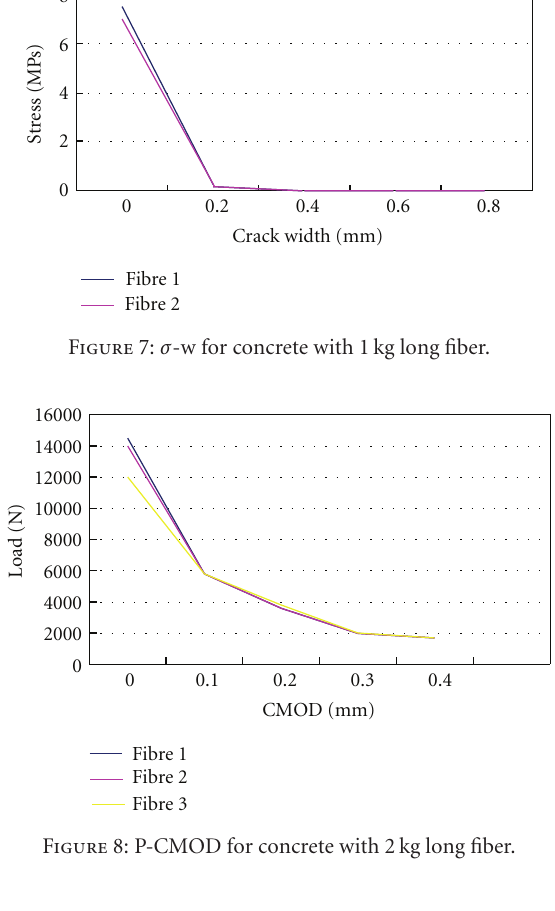
Figure 10: P-CMOD for concrete with 2kg short